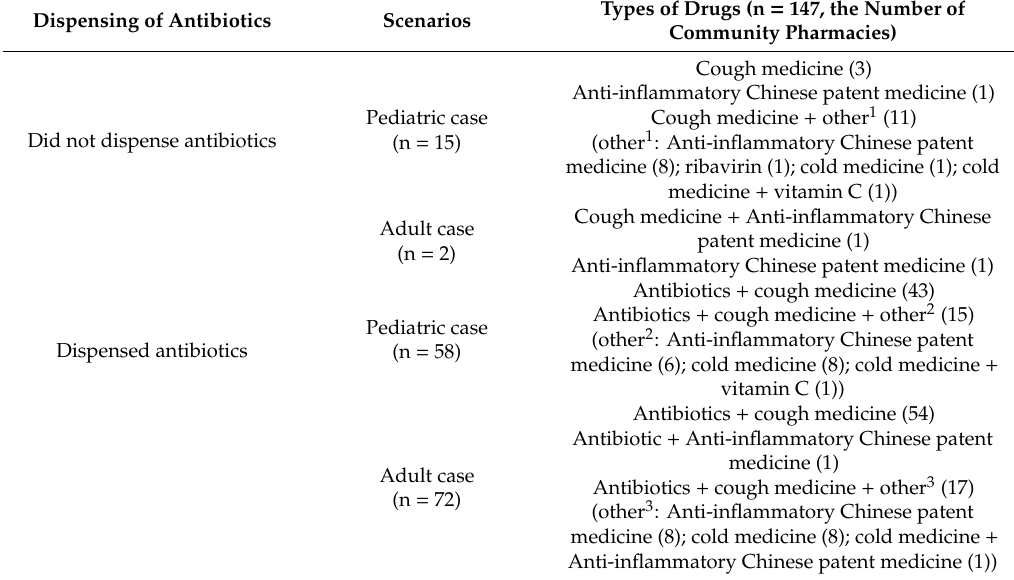
Table A2. Types of dispensing medicines in community pharmacy visits in Shenyang. Dispensing of Antibiotics